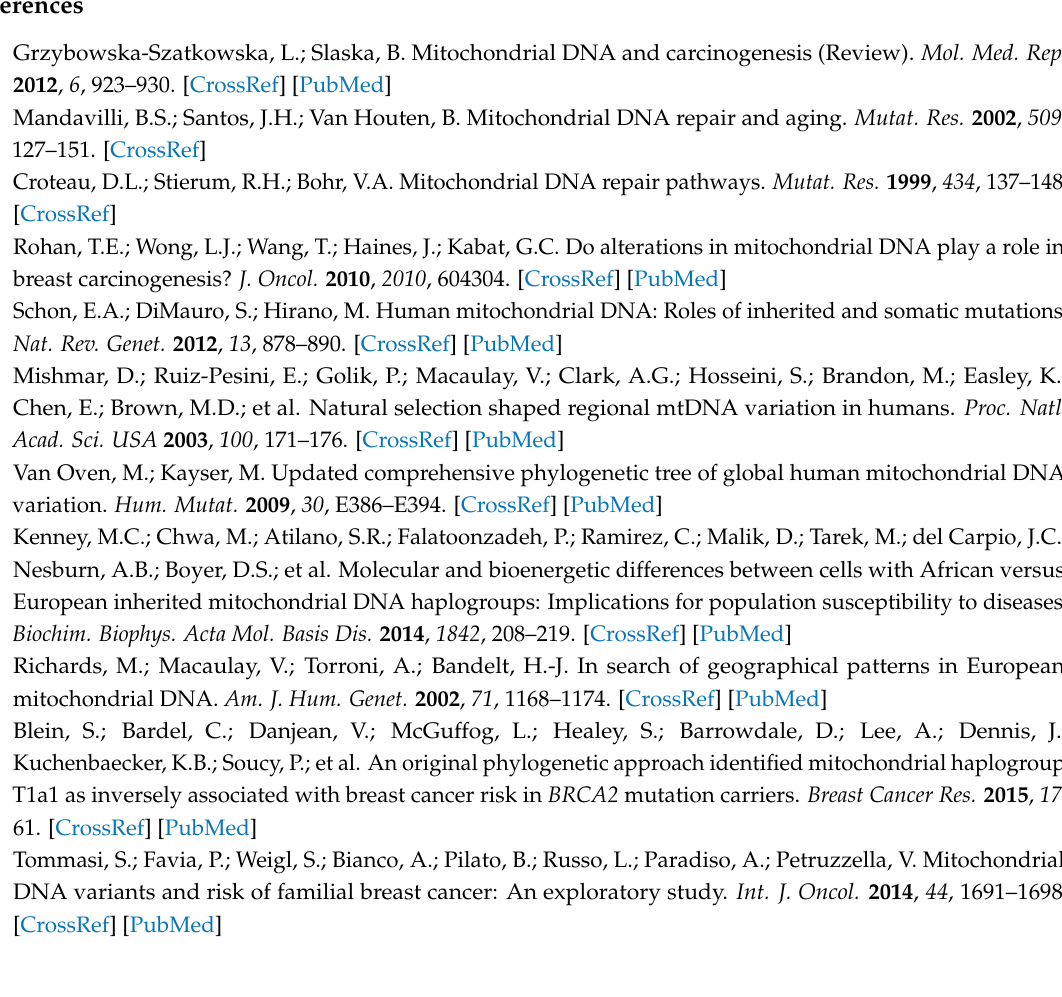
Breast cancer risk factors and major mtDNA haplogroups in ALSPAC mothers of European ancestry, unadjusted analysis, Table S5: Breast cancer risk factors and major mtDNA haplogroups in ALSPAC children of European ancestry, unadjusted analysis, Table S6: p -values obtained in the adjusted analysis using a quality score threshold of >90% compared to >80%, Figure S1: Top two principal components (PCs) by mtDNA haplogroup in ALSPAC mothers, Figure S2: Top two principal components (PCs) by mtDNA haplogroup in ALSPAC